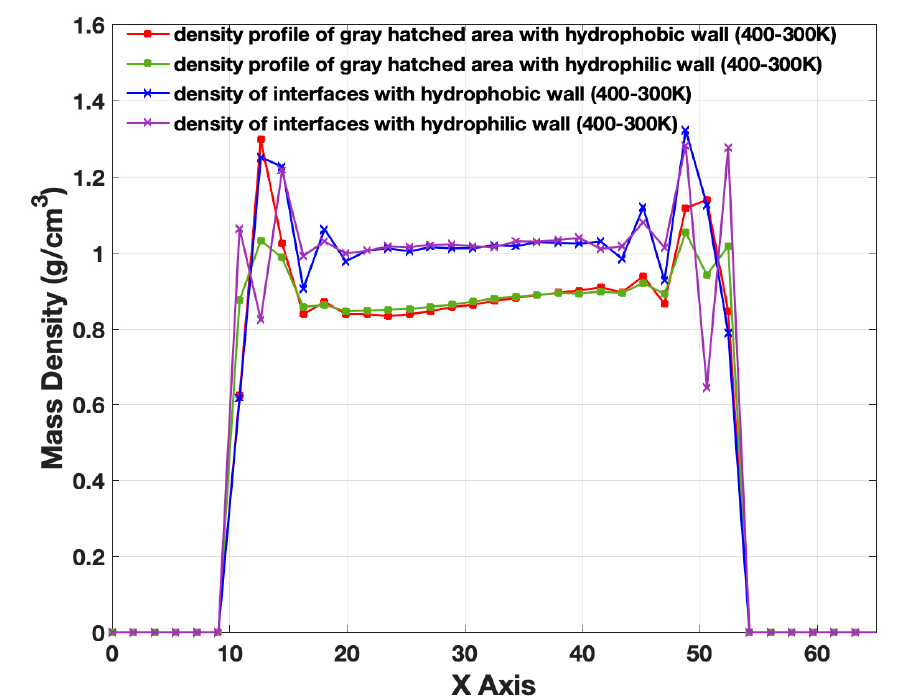
Figure 8. Mass density profiles of water along the X -axis (Figure 1) when the copper wall is hydrophobic or hydrophilic, corresponding to cases B5 and E5 in Tables 1 and 2. The red and green lines represent the regions shown as the bulk phase (grey hatched areas) and the adjoining interface regions (green hatched areas) shown in Figure 1. The blue and purple lines, respectively, show the interface regions (red hatched areas) and the adjoining “double” interface regions (unhatched white) shown in Figure 1.